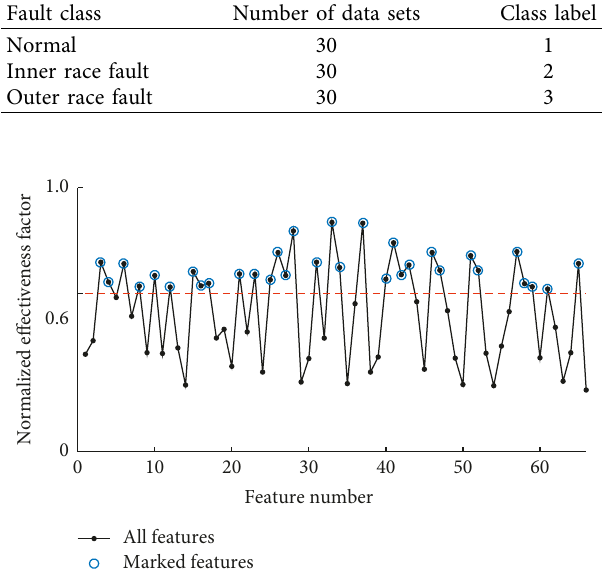
Figure 17: The marked features of IMFs components derived from MBMD decomposition.